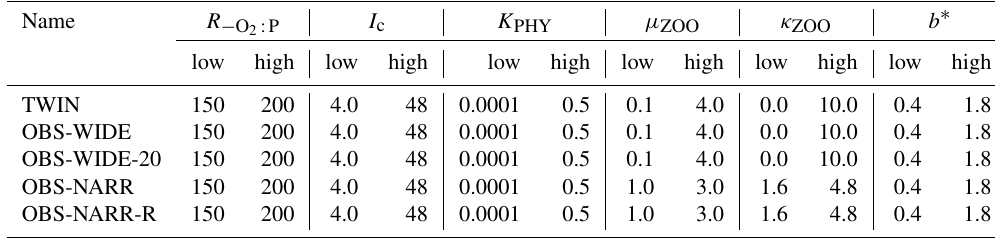
Table 2. Experimental setup of optimization. “low” and “high” indicate boundary constraints of the optimizations, respectively. Name R O 2 P I c K PHY µ ZOO κ ZOO b ∗ − : low high low high low high low high low high low high TWIN